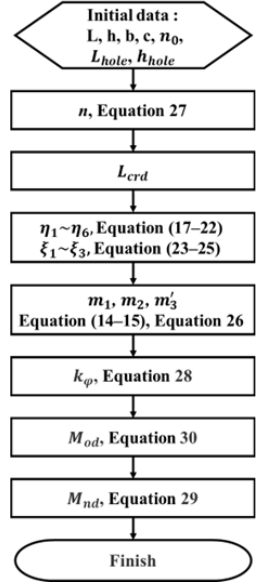
Figure 10. Calculation process of the critical moment of distortion buckling mode.